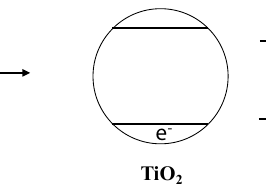
Figure 2. Förster energy transfer mechanism.